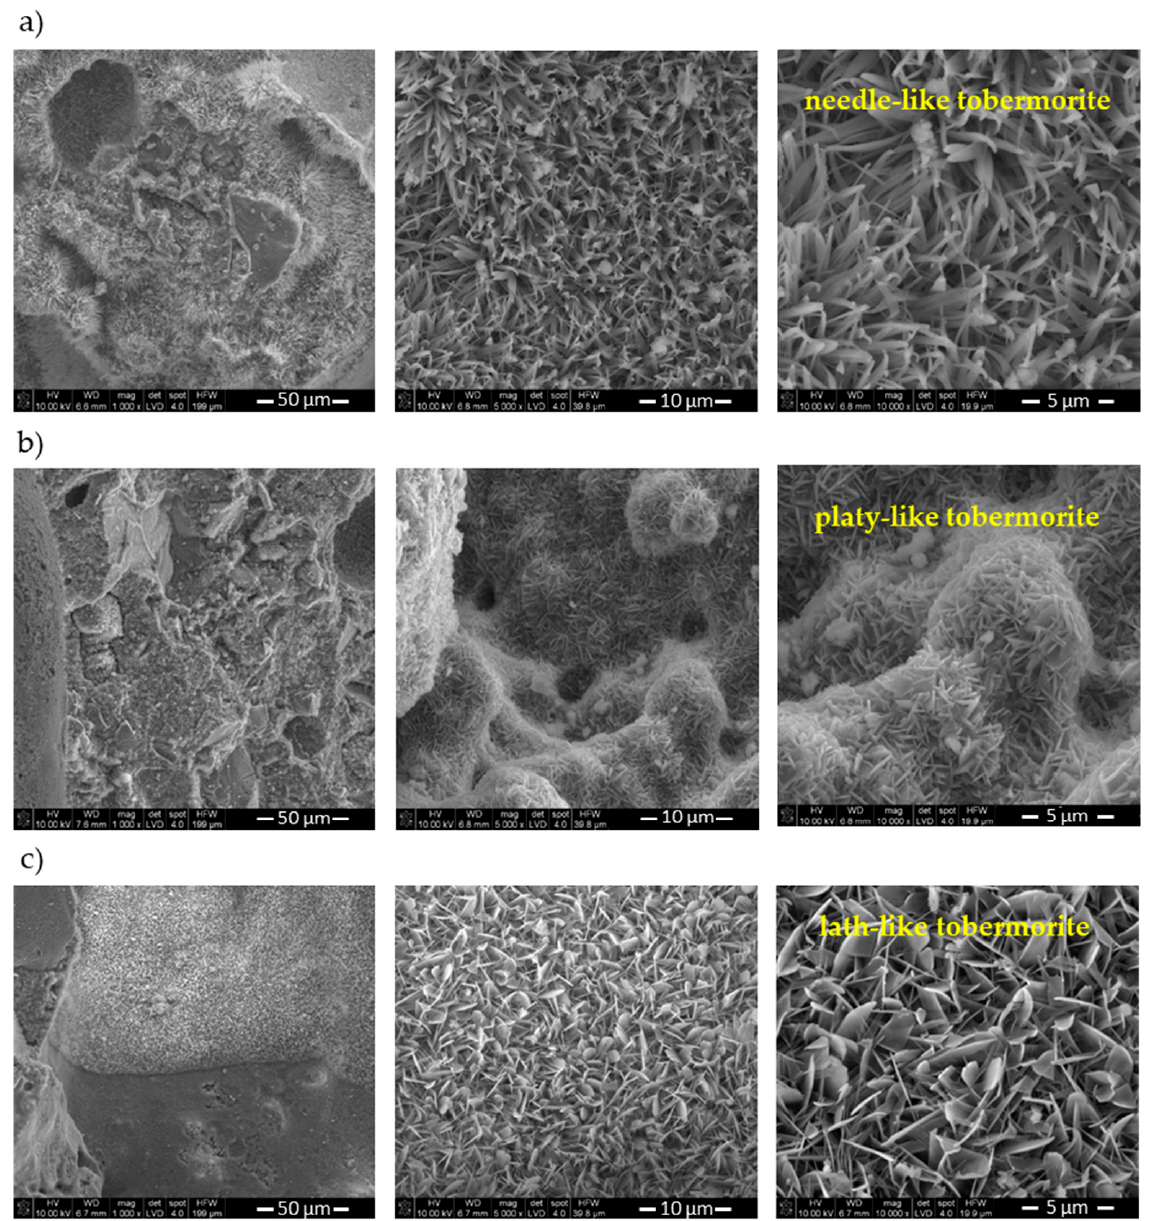
Figure 5. SEM microphotograph of AAC samples: ( a ) reference sample; ( b ) R-AAC; ( c ) C-AAC.